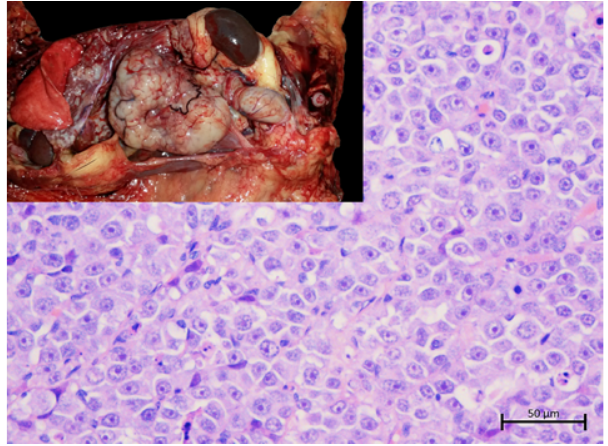
Figure 3: Metastatic seminoma. Neoplastic cell invasion of the vertebral bone and spinal cord (HE stain, bar = 200 µ m).